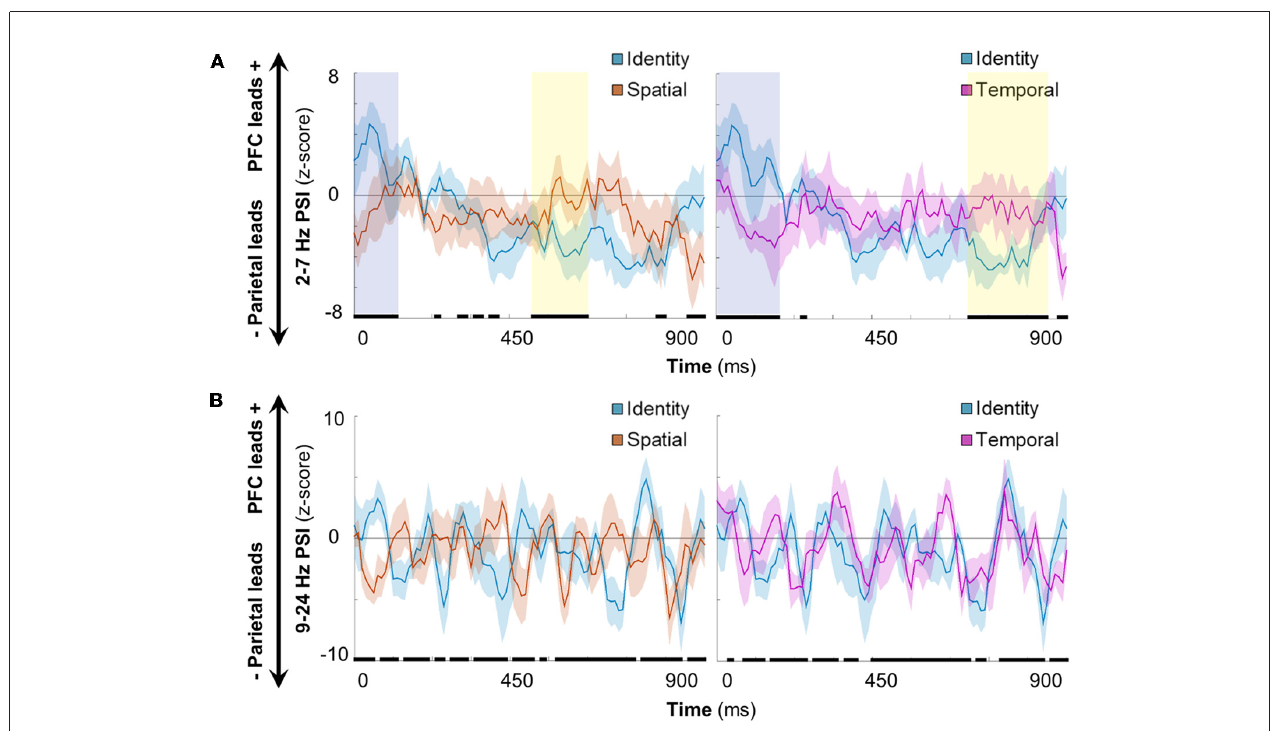
FIGURE 5 | Spatiotemporal processing connectivity effects. (A) Grand mean time-resolved delta-theta PSI over the processing interval for the contrast between identity and spatial (left)/temporal (right) conditions. Data are represented as mean ± SEM across subjects; positive values indicate that the PFC leads the parietal cortex and negative values indicate that the parietal cortex leads the PFC. Black marks indicate the timepoints of significant condition effects at the false discovery rate (FDR)-corrected threshold of 0.05. Shaded epochs represent effects that were sustained for >100 ms, color-coded by the direction of effects: cooler, identity > spatial/temporal; warmer, spatial/temporal > identity. Orange, spatial trials; blue, identity trials; pink, temporal trials. (B) Equivalent to (A) : alpha-beta PSI did not show sustained effects for one condition or the other in either contrast.